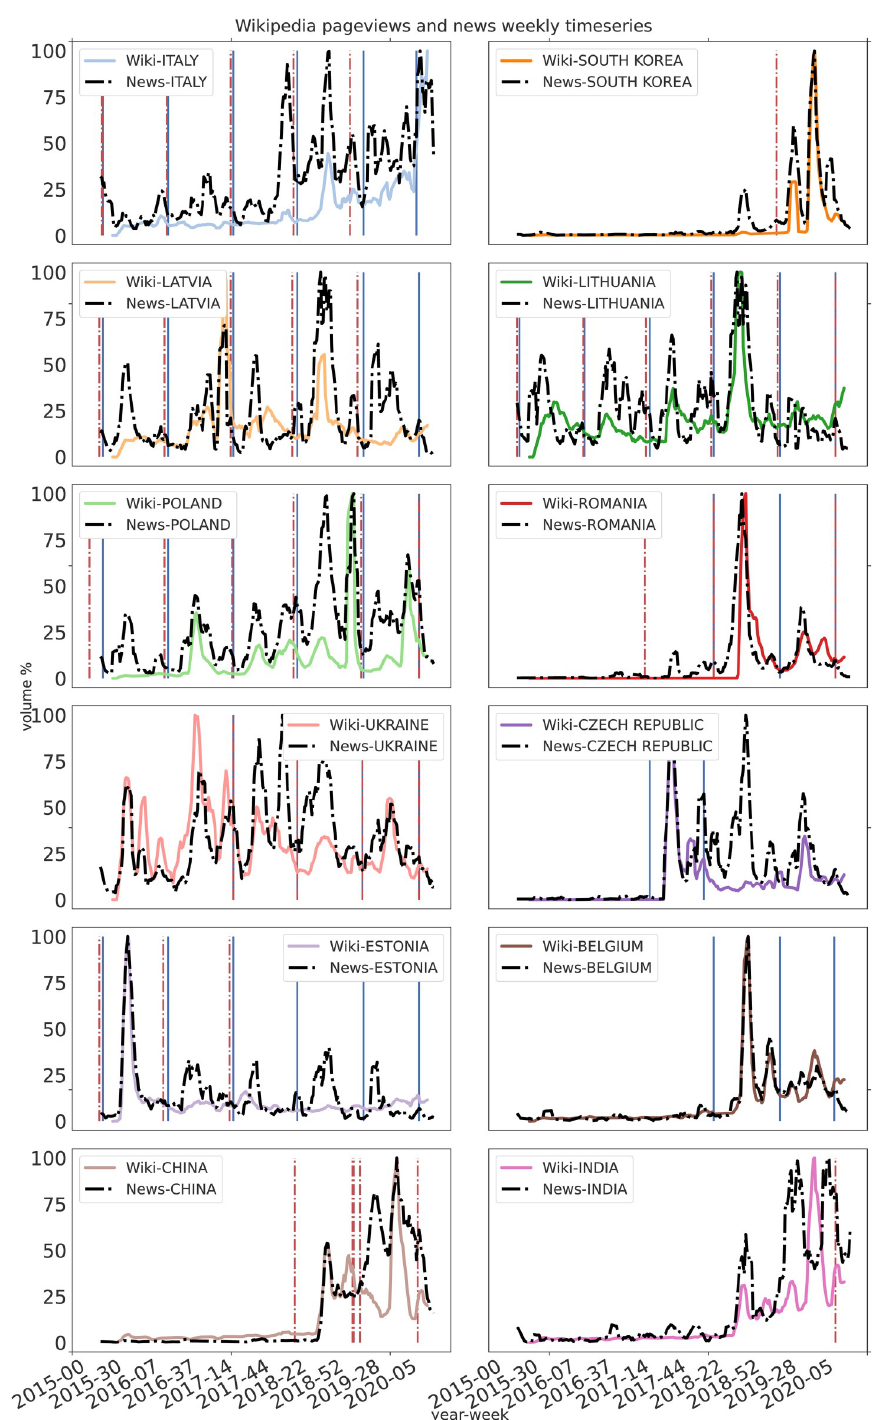
Fig 1. Weekly moving average of Wikipedia page view count, colored-solid lines, news volume, dotted-black lines, and ASF surveillance cases reports for domestic pigs, dashed-red vertical lines, and wild boars, solid blue vertical